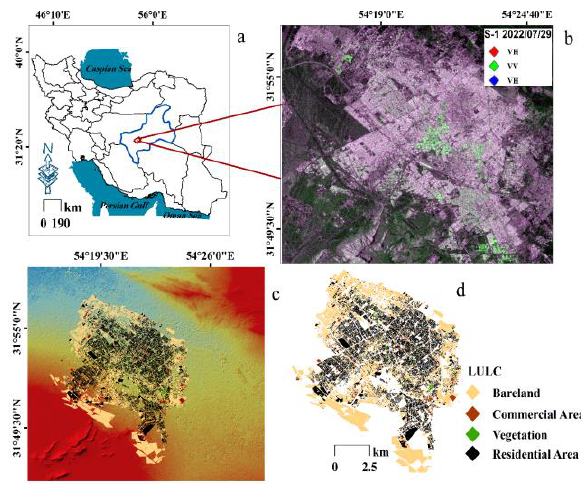
Figure 1. Location and geographic context of the Yazd city in central Iran (a), Sentinel1 image RGB: VH, VV, VH (b), SRTM 1sec of Yazd city (c), and (d) land use land cover (LULC) map of Yazd city.